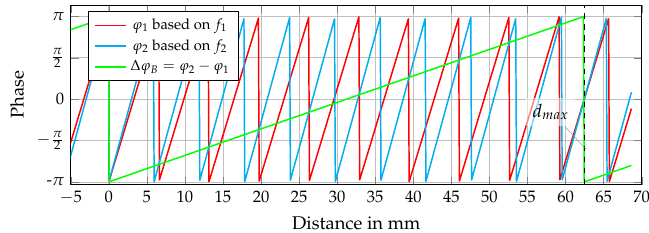
Figure 20. Phase jumps due to six-port-related unambiguity at CW and FSK